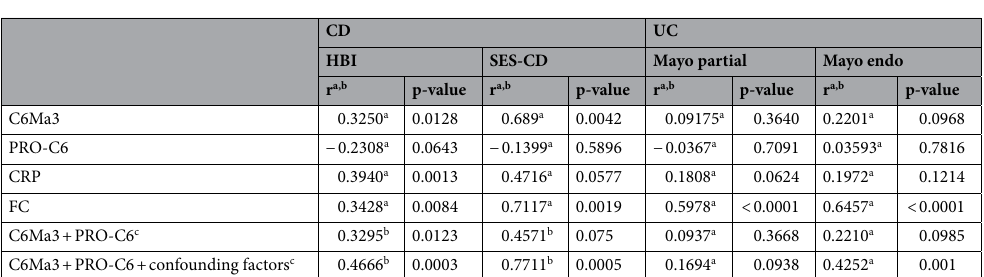
Table 4. Correlations between biomarkers and clinical and endoscopic disease activity scores. Correlations between clinical (HBI and Mayo partial) and endoscopic scores (SES-CD and Mayo endo) and the biomarkers C6Ma3, PRO-C6, CRP and FC. a Spearman r; b pearson r. Statistical significance was defined as p < 0.05. c Least squares multiple regression model. Confounding factors: age, BMI, gender, and